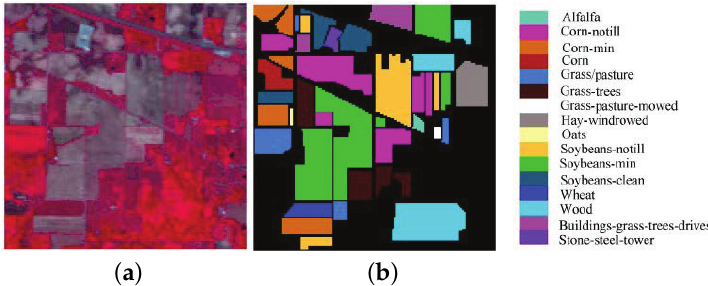
Figure 5. Indian Pines dataset. ( a ) Three-band false-color composite. ( b ) Ground-truth map. Table 1. Sample size for Indian Pines